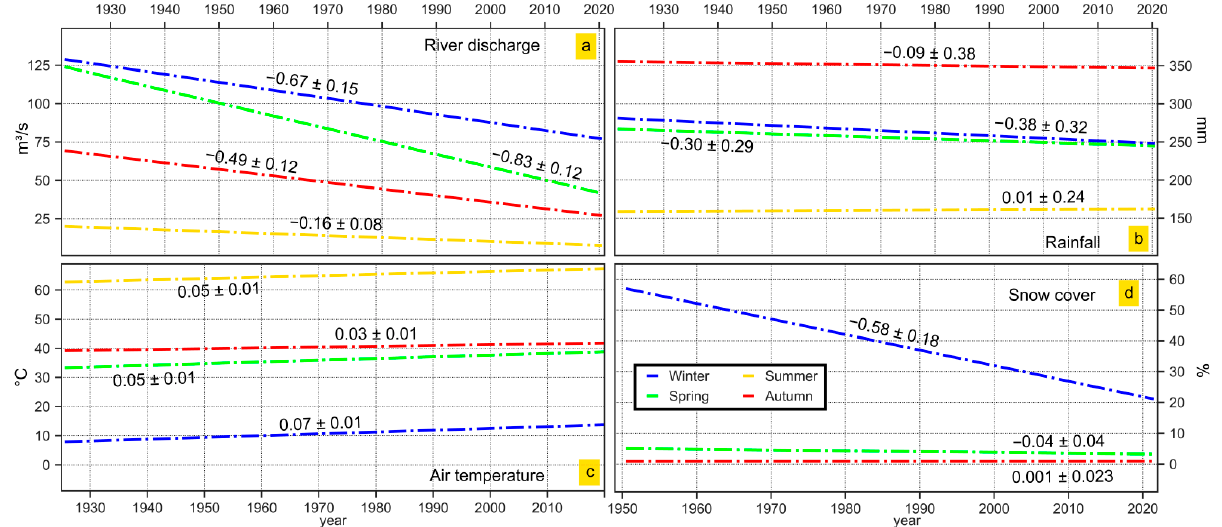
Figure A2. The seasonal trends computed for river discharge ( a ), rainfall ( b ), air temperature ( c ), and snow cover ( d ).